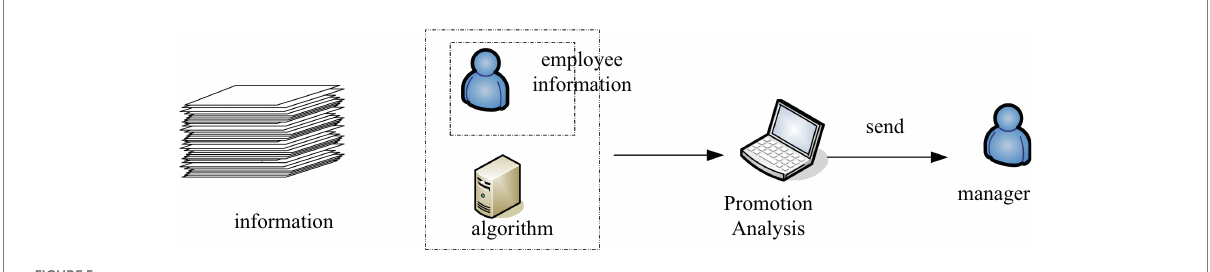
FIGURE 5 Employee promotion phase algorithm-related model.